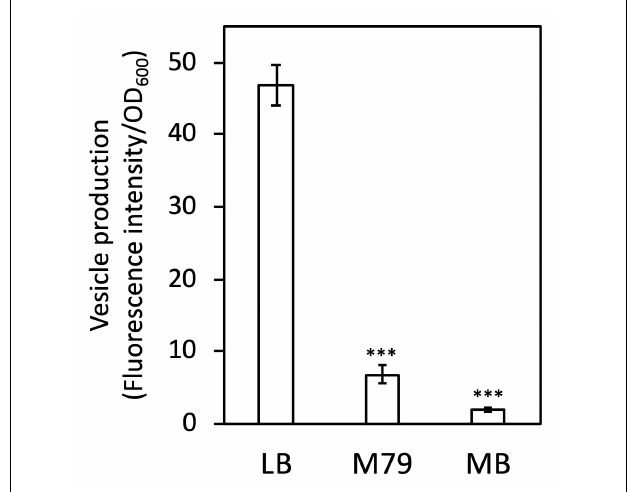
FIGURE 1 | Vesicle productivity of S. vesiculosa HM13 in different media. EMVs of S. vesiculosa HM13 cultured in different media were quantified by lipid staining with a lipophilic fluorescent molecule, FM4-64. The data are the means ± standard errors of the values from three independent batches. Statistical analysis was performed using two-tailed unpaired Student’s t -test. ∗∗∗ indicates p < 0.01, compared with